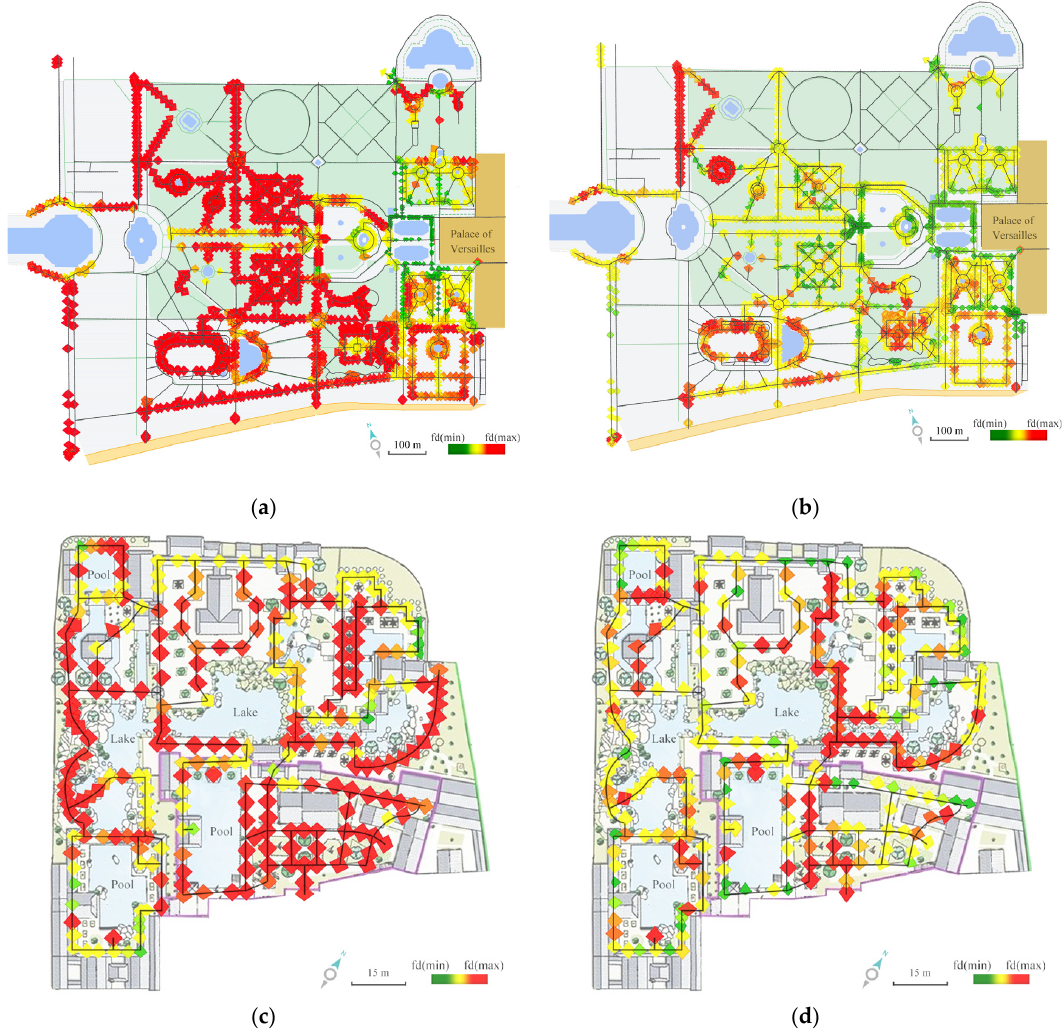
Figure 4. Based on the FDT method and the proposed FDH method, the fractal dimension distribution in two gardens. ( a , b ) the fractal dimension distribution in the Gardens of Versailles based on the FDT method ( a ) FDT and the proposed FDH method ( b ) FDH; ( c ) FDT ( d ) FDH the fractal dimension distribution in the Qinghui Garden based on the FDT method ( c ) FDT and the proposed FDH method ( d ) FDH.